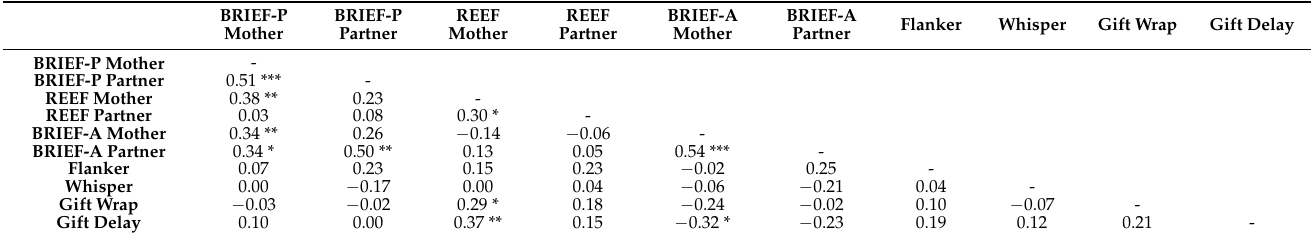
Table 3. Correlations between executive function measures and inhibitory control